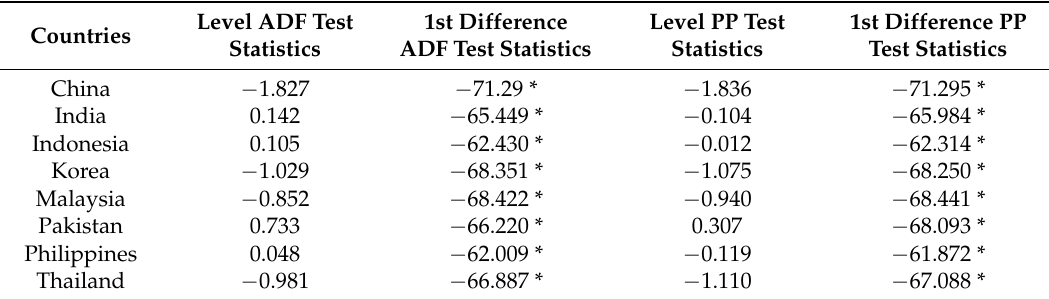
Table 3. Results of Augmented Dickey Fuller Test and Philips-Perron